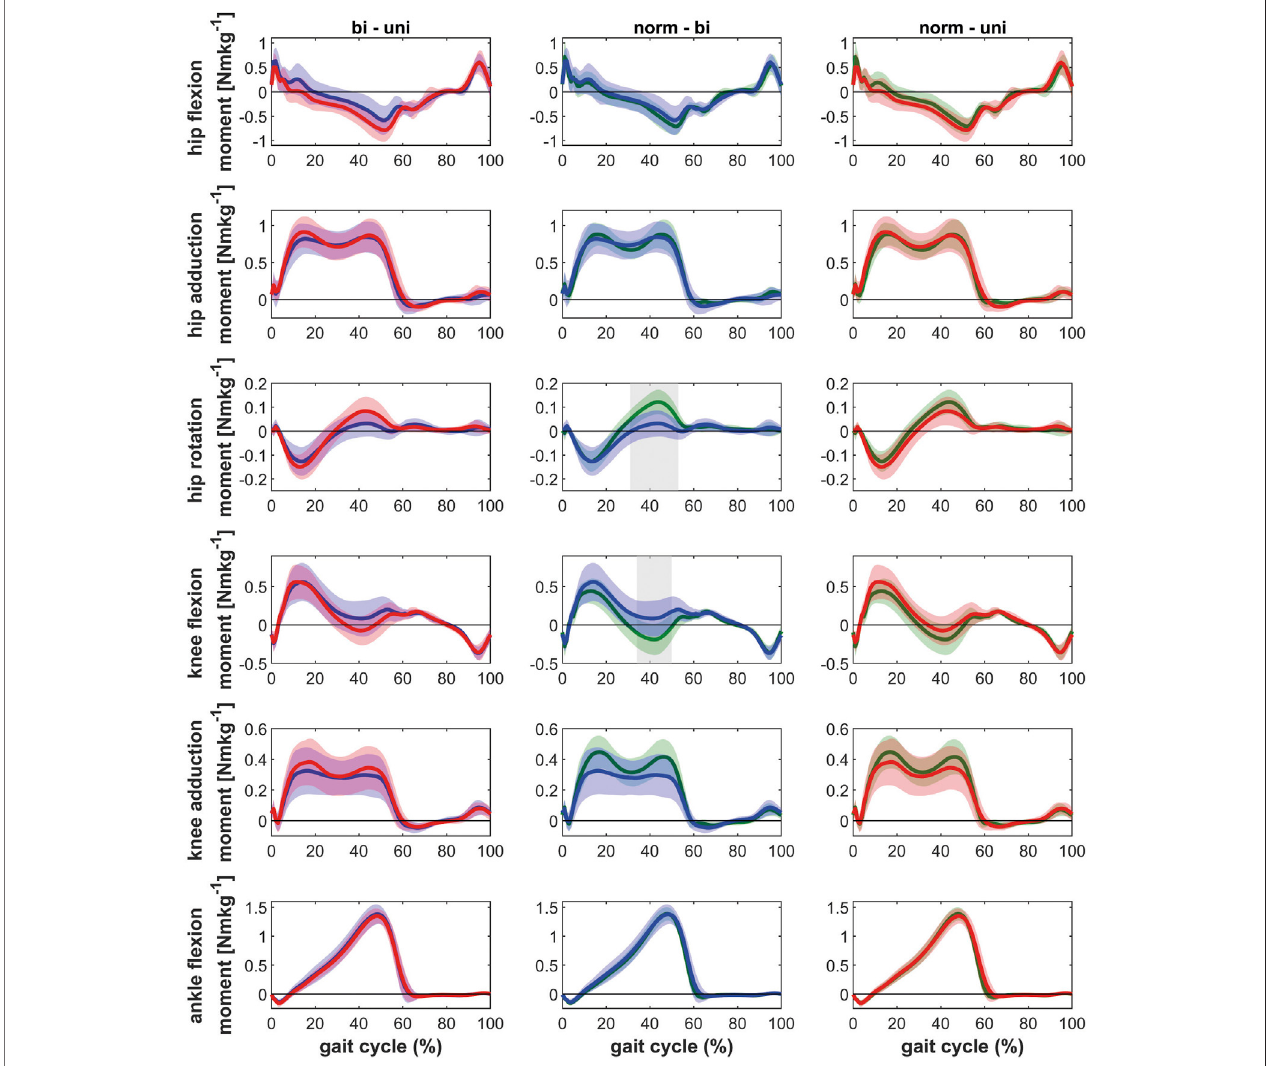
FIGURE 4 | Comparison of the kinetics of the contralateral leg between bilateral hip OA patients, unilateral hip OA patients and healthy controls. Mean and one standard deviation of the external joint moments. Shaded areas indicate statistical differences. Blue lines (cid:1) bilateral patients, red lines (cid:1) unilateral patients, green lines (cid:1) healthy controls. (A – C) hip fl exion/extension moment: fl exion (+)/extension ( − ); (D – F) hip adduction/abduction moment: adduction (+)/abduction ( − ); (G – I) hip rotation moment: internal rotation (+)/external rotation( − ); (J – L) knee fl exion/extension moment: fl exion (+)/extension ( − ); (M – O) knee adduction/abduction moment: varus (+)/valgus ( − ); (P – R) ankle dorsi fl exion/plantar fl exion moment: dorsi fl exion (+)/plantar fl exion ( −